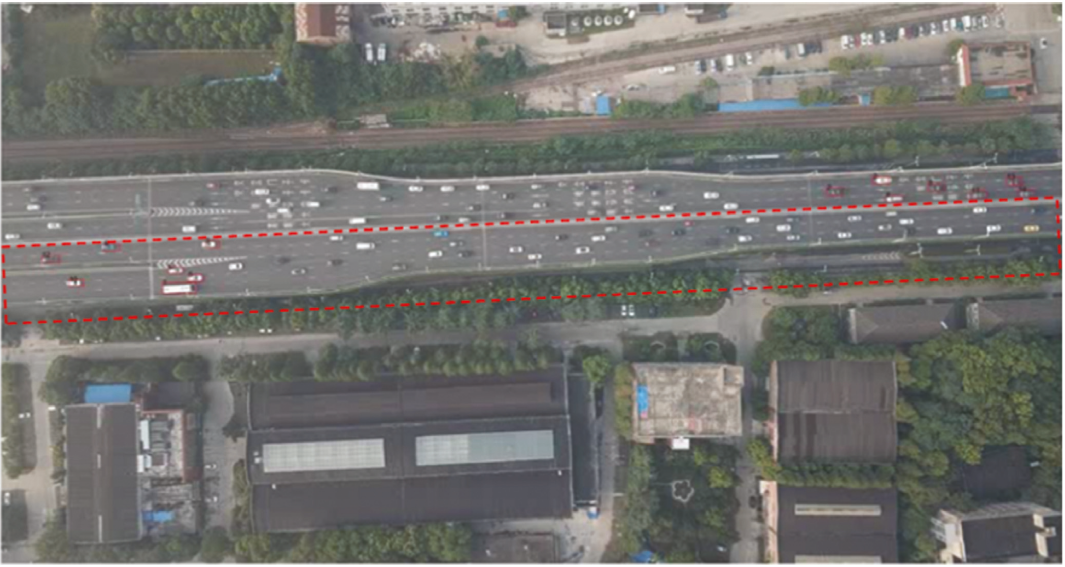
Figure 2: Top view of the study section captured by the drone. Table 1: Example of trajectory data